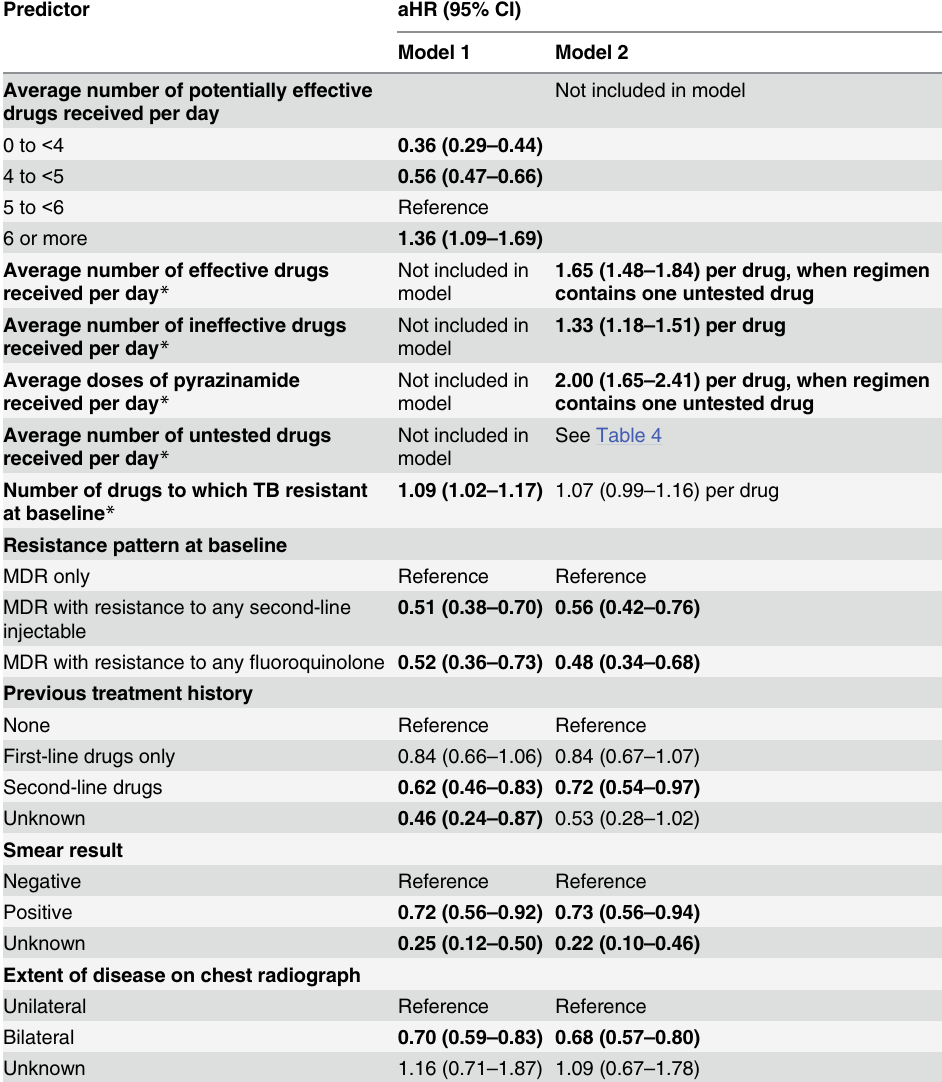
Table 3. Multivariable models for the association between regimen composition and sputum culture